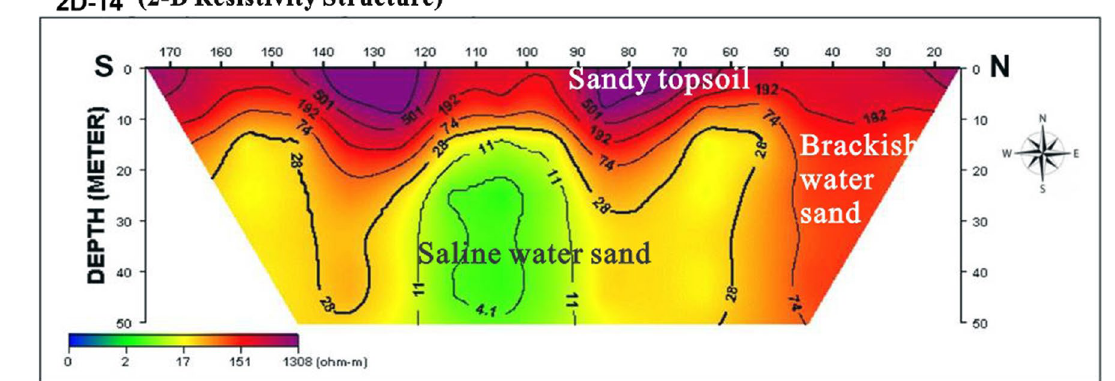
Fig. 18 Resistivity imaging of Traverse 2D-14